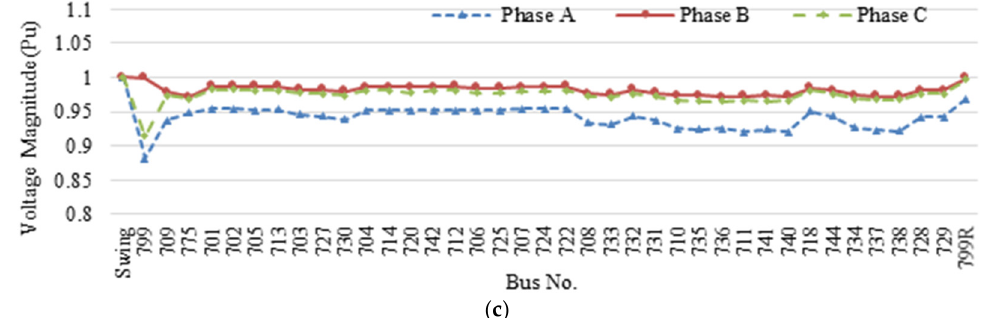
Figure 6. Simulation result of the bus voltage of the IEEE 37-bus test system: ( a ) before optimization; ( b ) after first stage; and ( c ) after second stage.